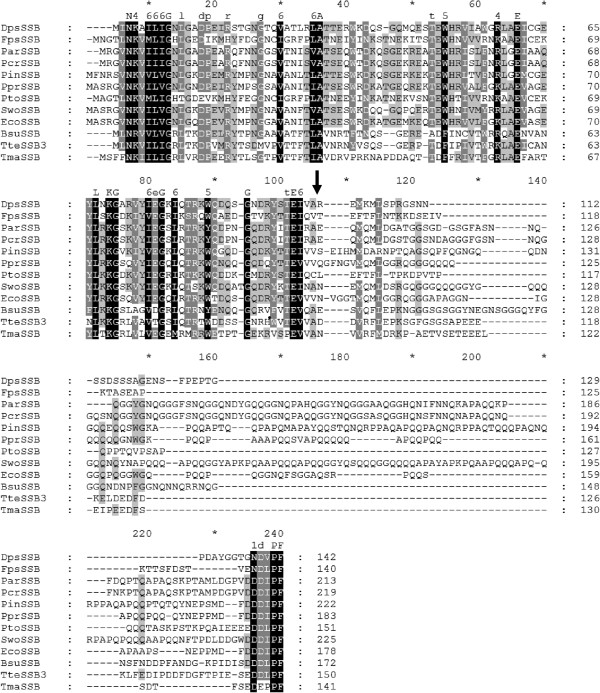
The multiple amino acid alignment of the SSB proteins under study, with the SSBs from psychrophilic, mesophilic and thermophilic bacteria. The alignments were performed by dividing the amino acids into six similarity groups: group 1 V, L, I, M, group 2 W, F, Y, group 3 E, D, group 4 K, R, group 5 Q, D, and group 6 S, T. The capital letters represent single amino acid codes. White fonts on black boxes represent 100% similarity, white fonts on grey boxes denote <80% similarity, and black fonts on grey boxes show <60% similarity. Abbreviations: DpsSSB Desulfotalea psychrophila (NCBI Reference Sequence: WP_011189820.1), FpsSSB Flavobacterium psychrophilum (NCBI Reference Sequence: WP_011963776.1), ParSSB Psychrobacter arcticus (NCBI Reference Sequence: AAZ19531.1), PcrSSB Psychrobacter cryohalolentis (NCBI Reference Sequence: ABE75735.1), PinSSB Psychromonas ingrahamii (NCBI Reference Sequence: WP_011771629.1), PprSSB Photobacterium profundum (NCBI Reference Sequence: WP_011219846.1), PtoSSB Psychroflexus torquis (NCBI Reference Sequence: WP_015023871.1), SwoSSB Shewanella woodyi (NCBI Reference Sequence: WP_012323283.1), EcoSSB Escherichia coli K12 (NCBI Reference Sequence: YP_492202.1), BsuSSB Bacillus subtilis (NCBI Reference Sequence: NP_391970.1), TteSSB3 Thermoanerobacter tengcongensis MB4 (NCBI Reference Sequence: AAM25884.1), and TmaSSB Thermotoga maritima MSB8 (NCBI Reference Sequence: WP_004081225.1). An arrow indicates the boundary between the N-and C-terminal domains.